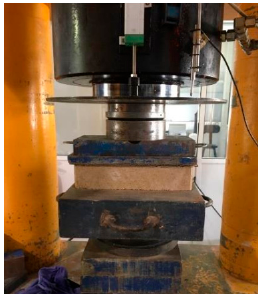
Figure 4. Compressive strength test.